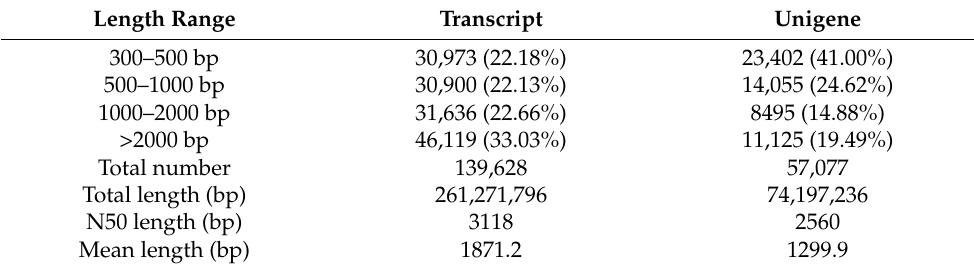
Table 2. Summary statistics of the D. hystrix gonadal transcriptome